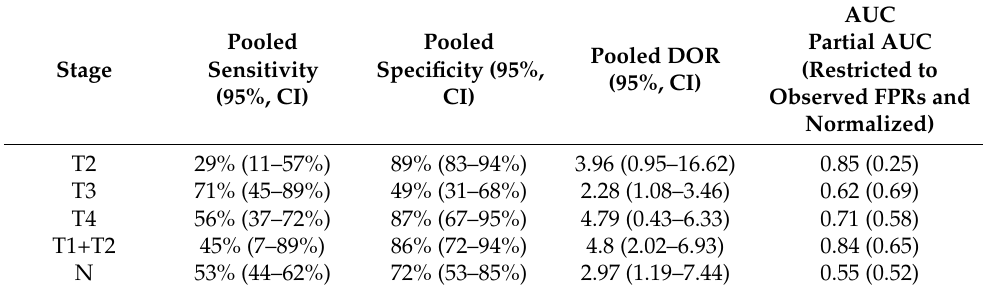
Figure 13. SROC curve describing the diagnostic performance of EUS in N0 restaging. Pooled sensitivity and specificity, AUC and partial AUC for T and N restaging are summarized in Table 2. Table 2. Pooled sensitivity, specificity, DOR and AUC for T2-T4, T1+T2 and N stage.